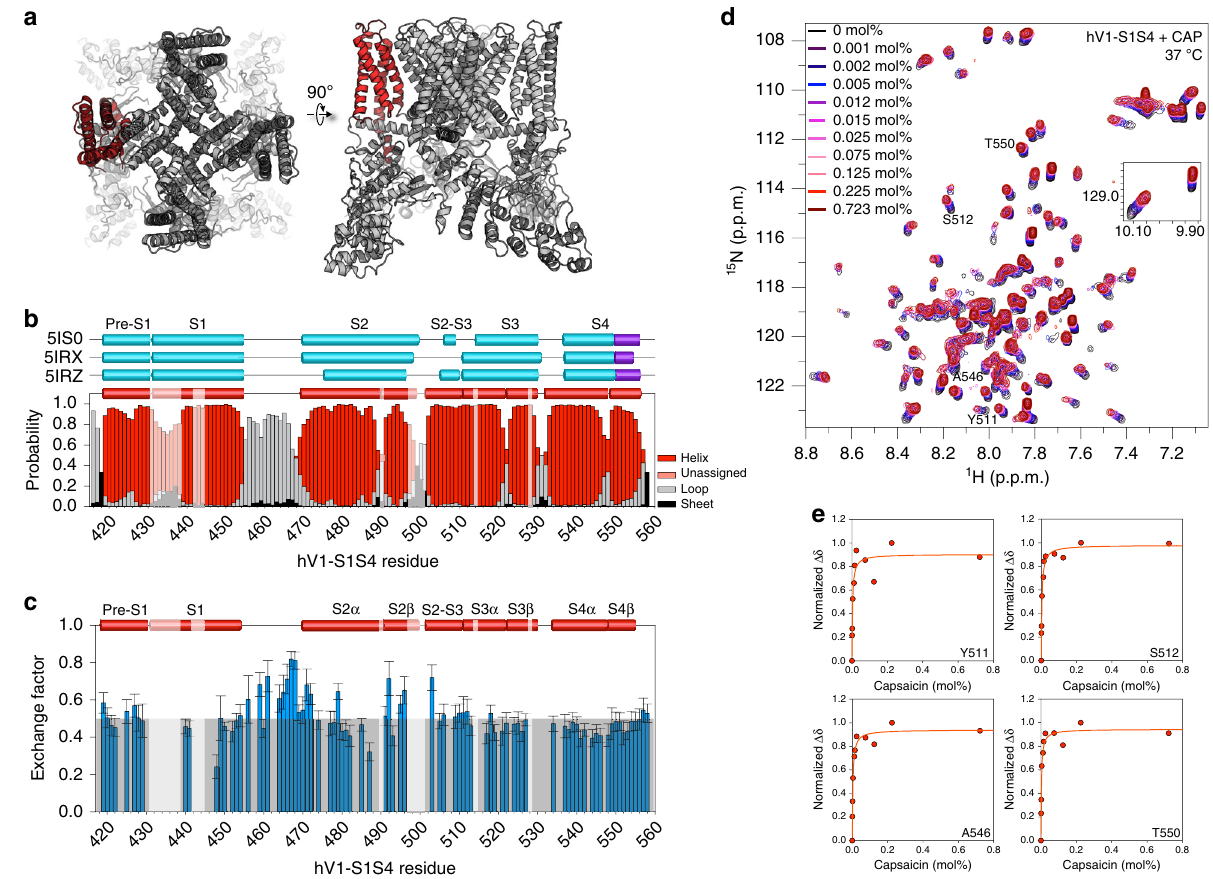
Fig. 1 The isolated human TRPV1 S1 – S4 domain is folded in a biologically relevant state and binds capsaicin at elevated temperatures. a Highlighted in red is the hV1-S1S4 construct shown in the rTRPV1 cryo-EM structure (PDB ID: 3J5P) and used throughout our studies. b Cryo-EM determined secondary structure information of rTRPV1 (cyan/purple) compared with the NMR-determined secondary structure (red) from hV1-S1S4 at 45 °C identi fi es the similarities and differences in secondary structure. The S4 3 10 helix is shown in purple. The unassigned region is blocked with opaque white boxes. c Deuterium/hydrogen (D/H) exchange factors show the hV1-S1S4 solvent accessibility is consistent with the anticipated membrane topology. As annotated in ( b ), unassigned residues are covered with opaque white boxes. Darker gray box represents the average value of exchange factors. Error bars represent per-residue fi tting error. d Superimposed 1 H- 15 N HSQC spectra of the hV1-S1S4 titration with capsaicin at 37 °C. e Canonical capsaicin binding residues include Y511, S512, T550, and A546, which show saturating binding isotherms as a function of capsaicin. Source data are provided as a Source Data fi